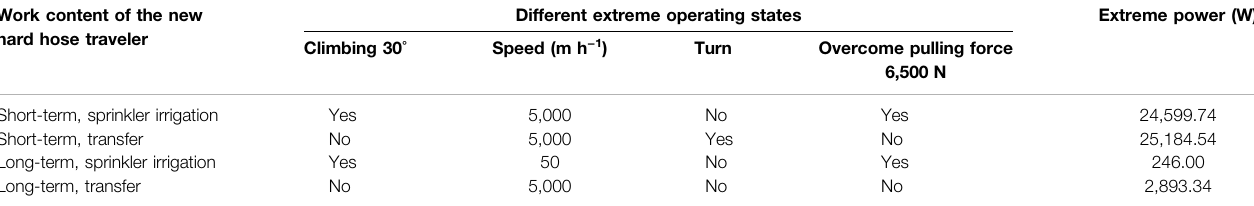
TABLE 9 | The extreme power of the new hard hose traveler in different operating